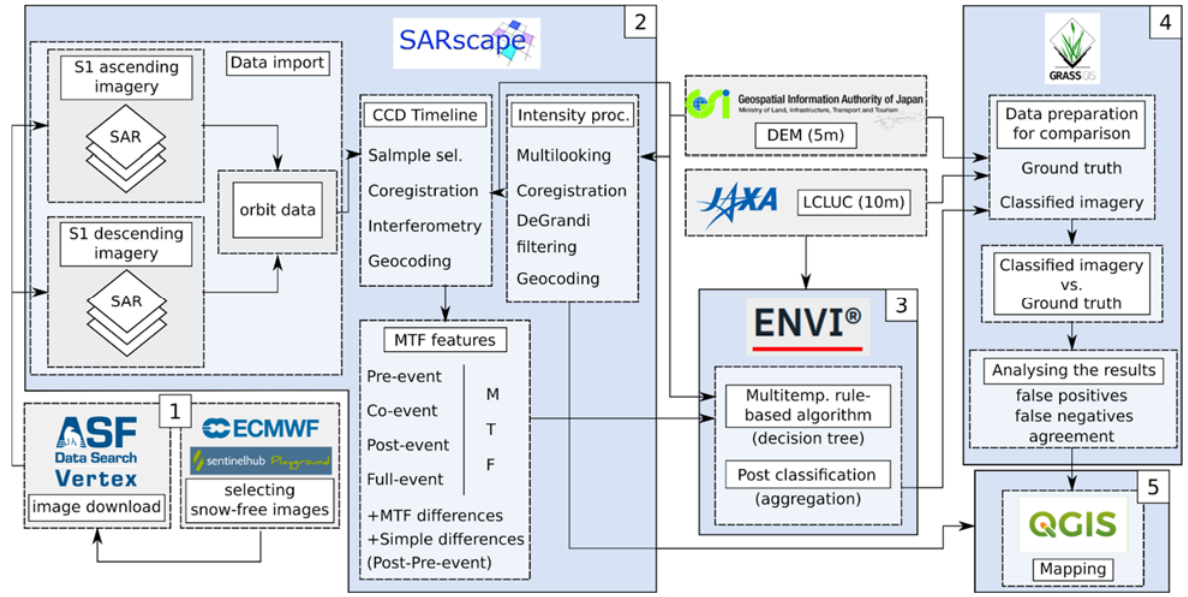
Figure 6. Scheme of data download and processing workflow. 1 = data selection and download, 2 = data import, coherence processing, multi ‐ temporal feature extraction, 3 = image classification, 4 = comparing classified images with ground truth, 5 = map preparation.